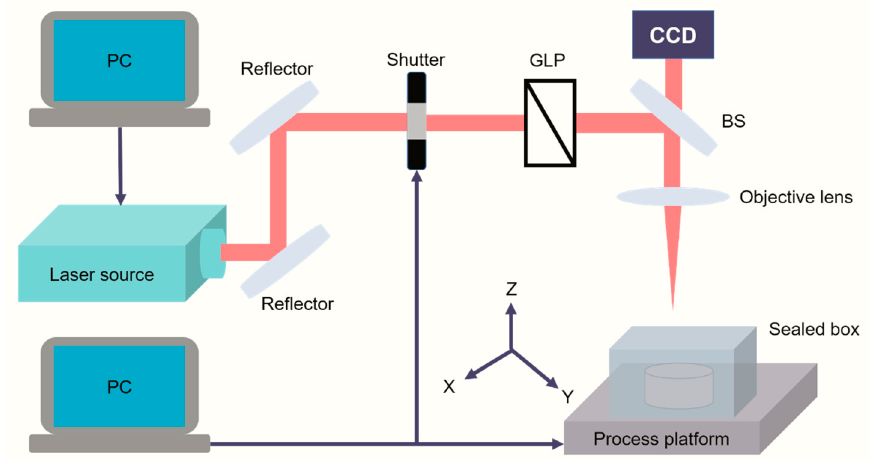
Figure 2. Schematic diagram of ultrashort pulse laser processing.